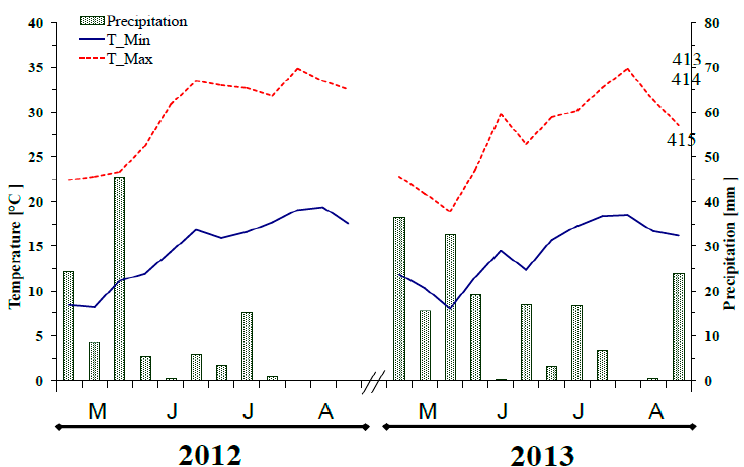
Figure 1. Weather data at 10-day intervals [maximum (—) and minimum (—) temperatures ( ◦ C), and rainfall (mm)] at the experimental site throughout the growing period of summer vegetable crops in 2012 and 2013.